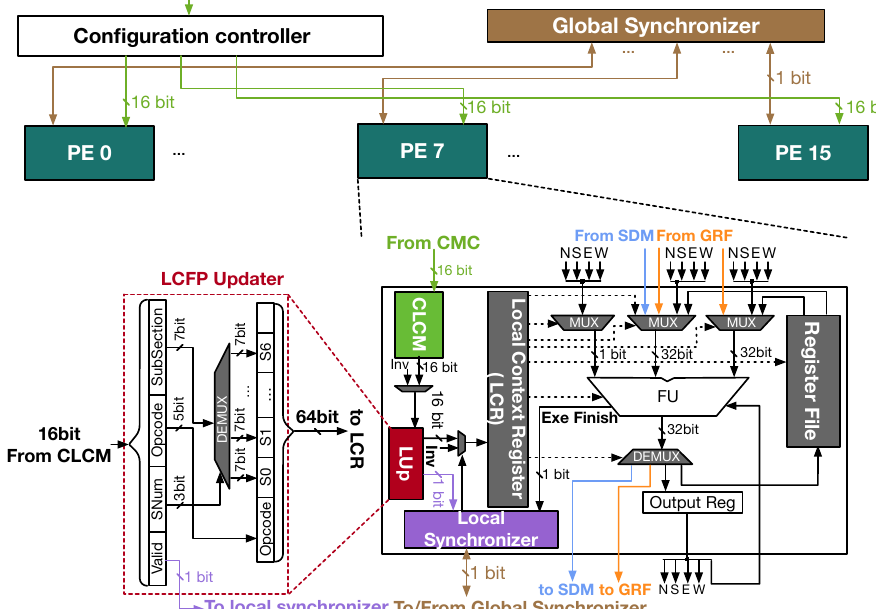
Figure 10. Architecture support for the distributed CFP-fetching CGRA. The distributed CFP-fetching CGRA does not change the synchronous manner of the execution. However, it removes some context-footprint redundancies caused by the unbalanced fetching of the CFPs between different PEs. For the same example in Figure 9c, PE0 must repeatedly fetch the same CFP (blue color part) in cycle i + 1 to align with the second CFP of PE1 even though it has only one different subsection to update. This design style eliminates the redundancy by adding Valid into the CFP for every PE and using the local synchronizer to manage the LCFP fetching and PE execution locally inside each